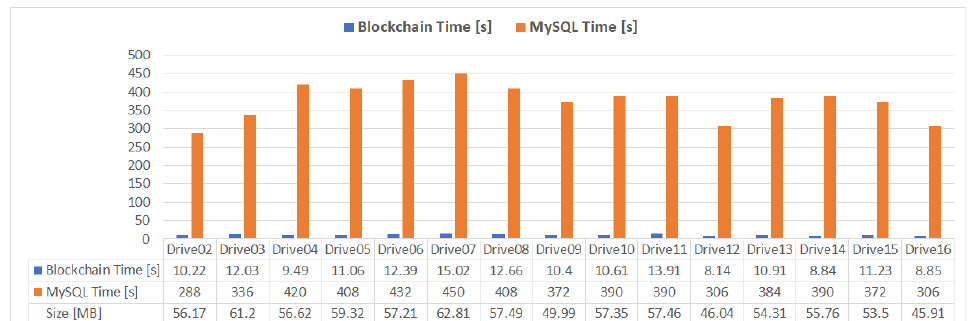
Figure 10. Blockchain and MySQL read